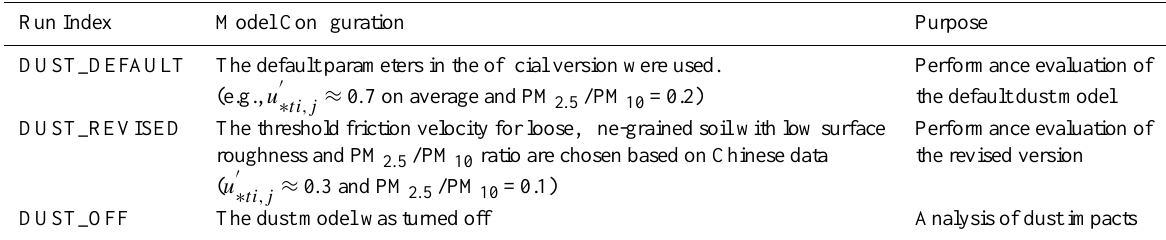
Table 2. Scenario design for model simulations.